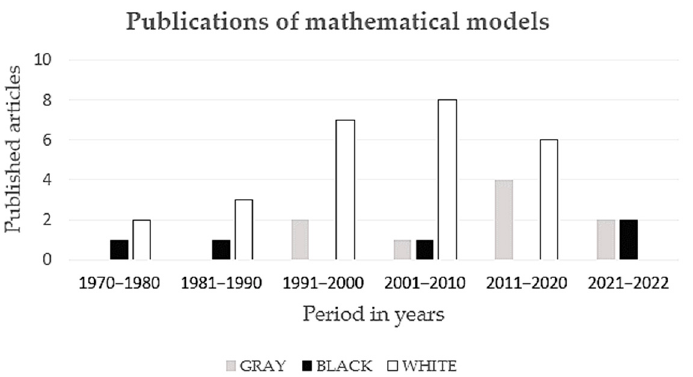
Figure 3. Mathematical models reported in the literature. The graph shows the representation of the number of published articles focused on mathematical models to estimate photosynthesis over time, classified by decades from 1970 to 2022.